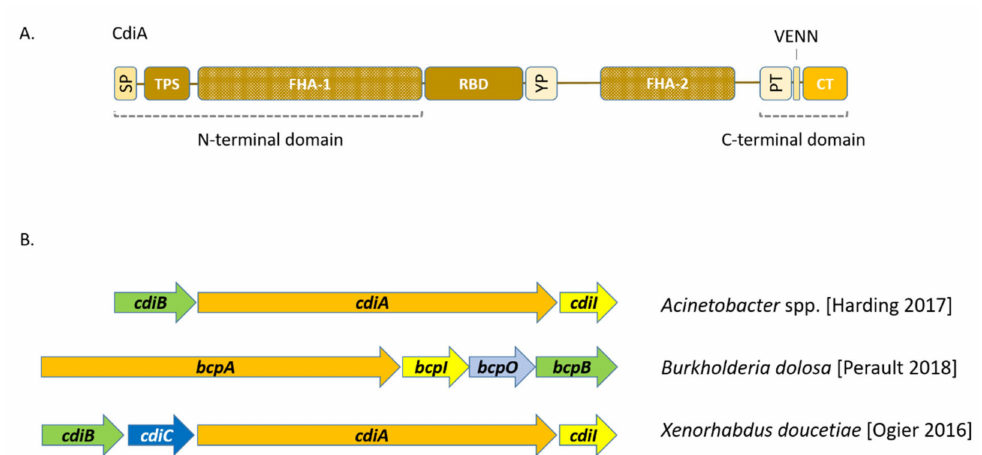
Figure 3. ( A ) CdiA domain architecture in E. coli . SP—signal peptide; TPS—two-partner secretory system; FHA-1,2—peptide repeats (regions 1, 2); RBD—receptor-binding domain;